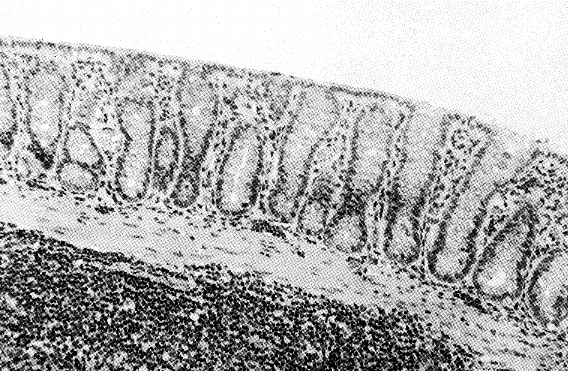
FIG. 1. Colon from control rats which was sampled from the middle third of the bowel. Note the intact surface epithelium and lymph nodule. (Magnification x 200, H & E stain) of erythema. Four colons had well-defined erosions. The mean number of erosions in the stress group was 0.5 +/- 0.7 (S.E.M.) and occurred only in the proximal two-thirds of the colon (Fig. 2). Subepithelial hemorrhages were occasionally pre- sent in the colons and were located near the surface epithelium. The columnar epithelium was lost and erosions extended almost to the base of the crypts but not into the muscularis mucosa (Fig. 3).